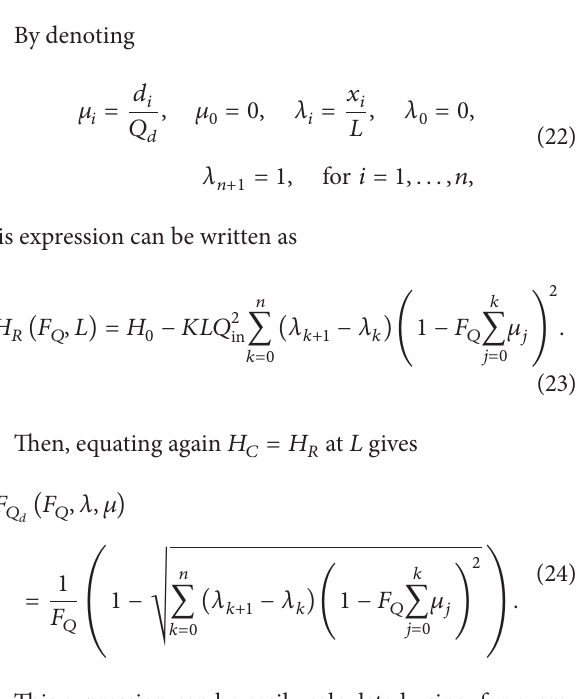
varying the location of the withdrawal point, specifically for values 𝜆 = 0.1 , 0.25, 0.5, and 0.9. The (straight dashed) line, corresponding to the 50% allocation rule, has also been represented. We can observe that only for 𝜆 = 0.25 does the dashed line match the correct piezometric head at the downstream end (also, observe that the lower curve in Figure 4, corresponding to 𝐹 𝑄 = 1 , contains the point ) = (0.25, 0.5) ). In the other cases, disagreements are (𝜆, 𝐹 𝑄 𝑑 not only important at the downstream end but all along the